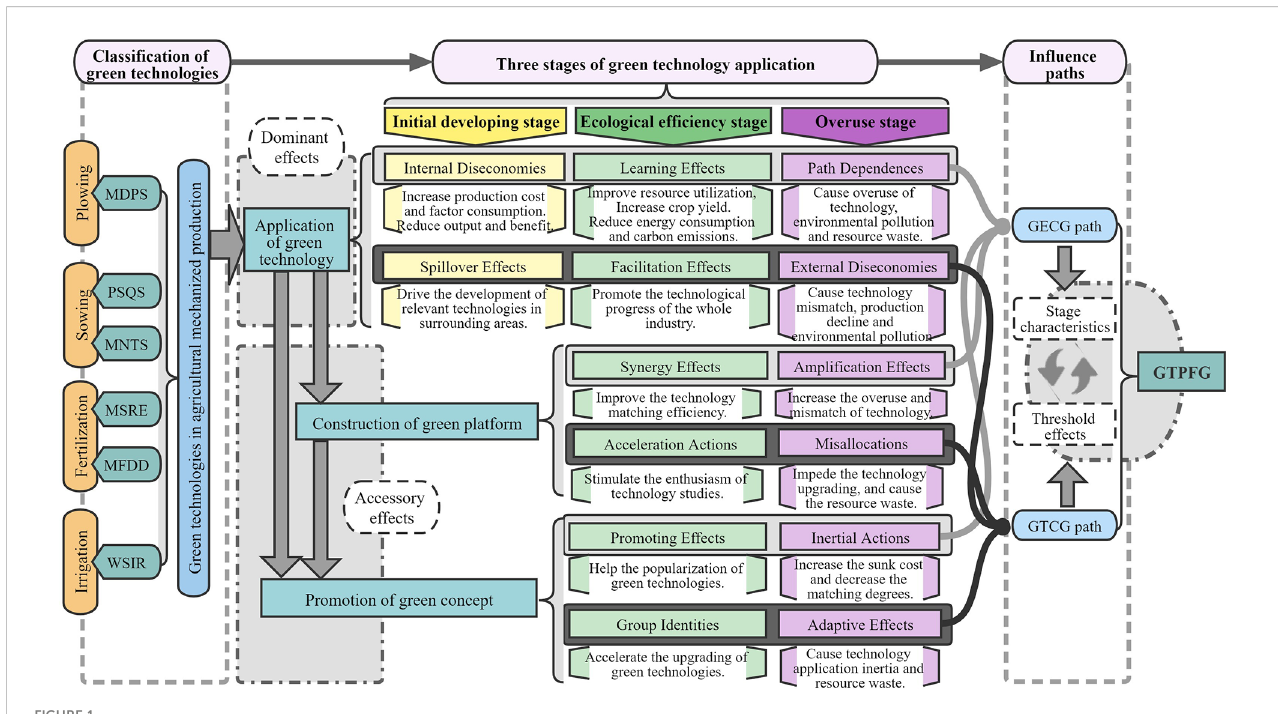
FIGURE 1 The in fl uence mechanism of green technology application on